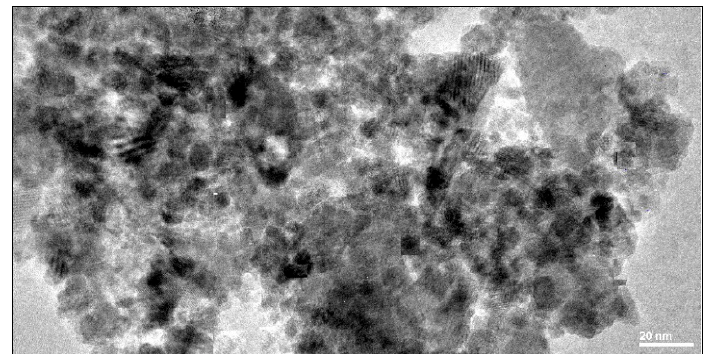
Figure 4. TEM images of the generated nanoparticles.